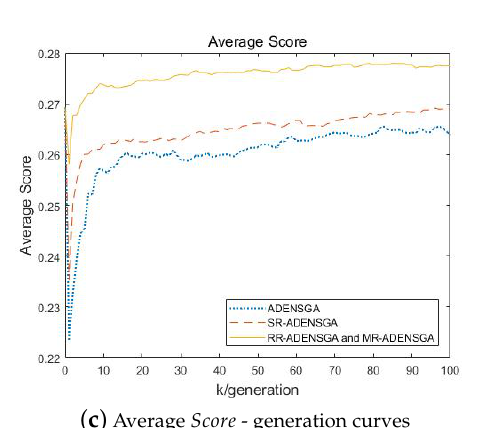
Figure 5. Comparison of Optimization Results of Different Algorithms Changing With Generation in Situation 1.